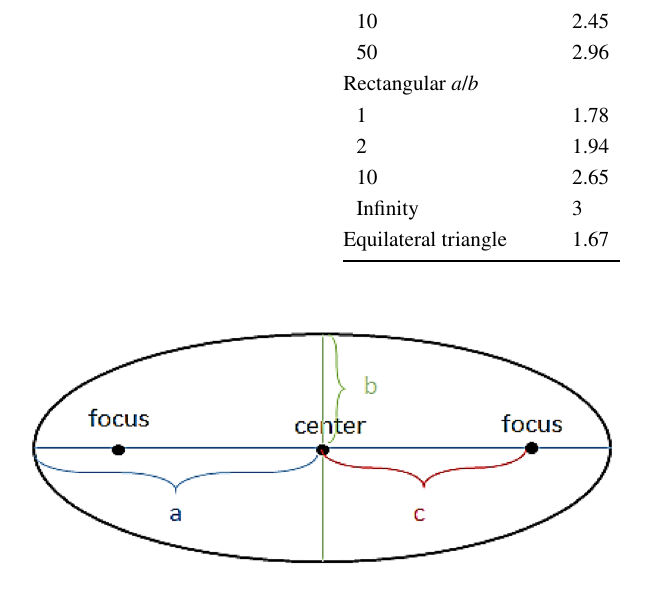
Fig. 3 Ellipse with its shape